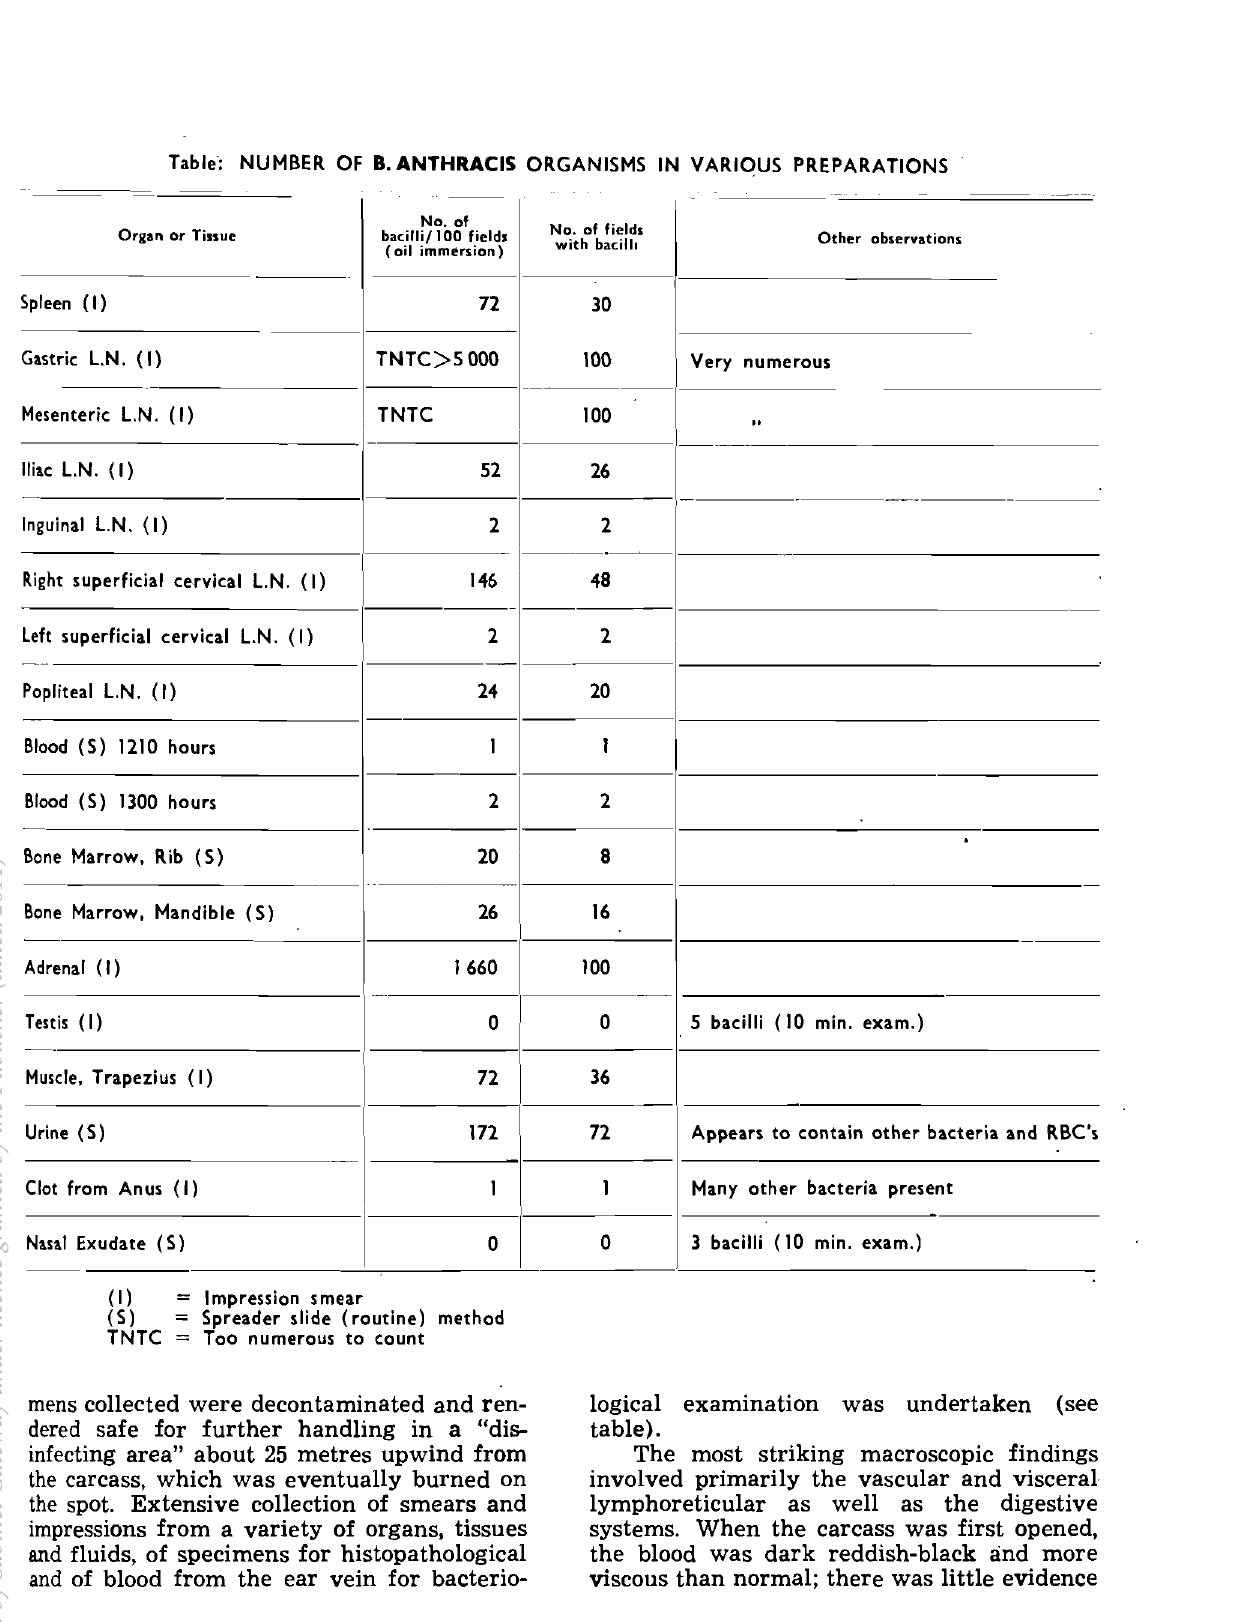
Table': NUMBER OF B. ANTHRACIS ORGANISMS IN VARlqUS PREPARATIONS -- Orean or